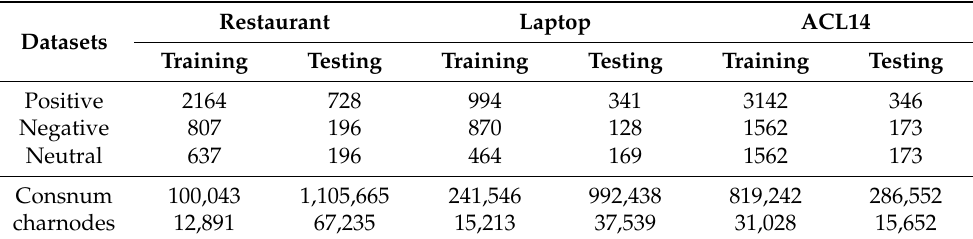
Table 1. Statistical results of SemEval2014 and ACL-14 baseline datasets. “ Consnum ” indicates the numbers of sentence construction. “ charnodes ” indicates the number of characters nodes used to build a topological